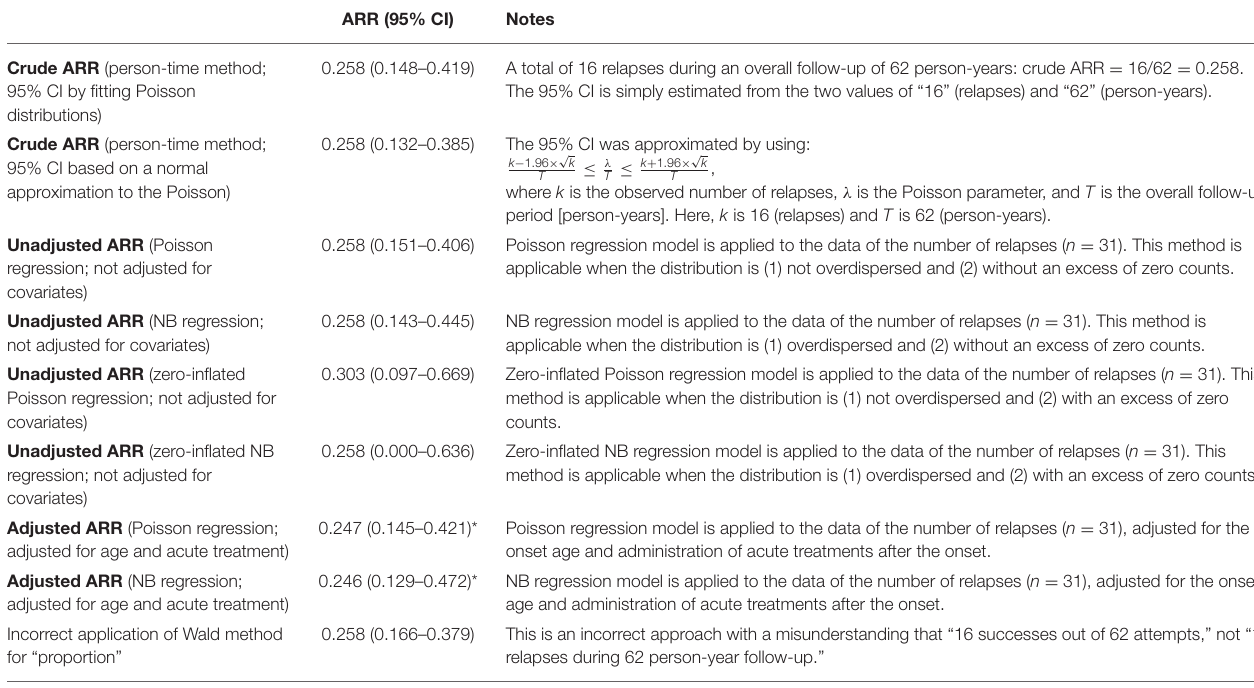
TABLE 1 | ARR and 95% CI with different statistical